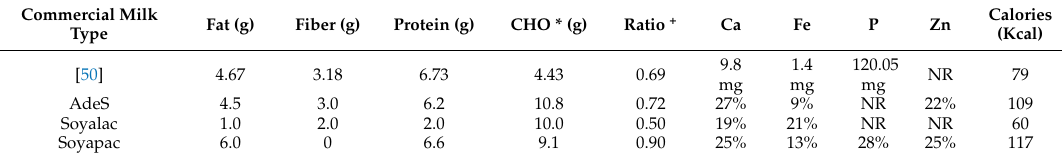
Table 2. Nutritional composition of different soymilk (per 1